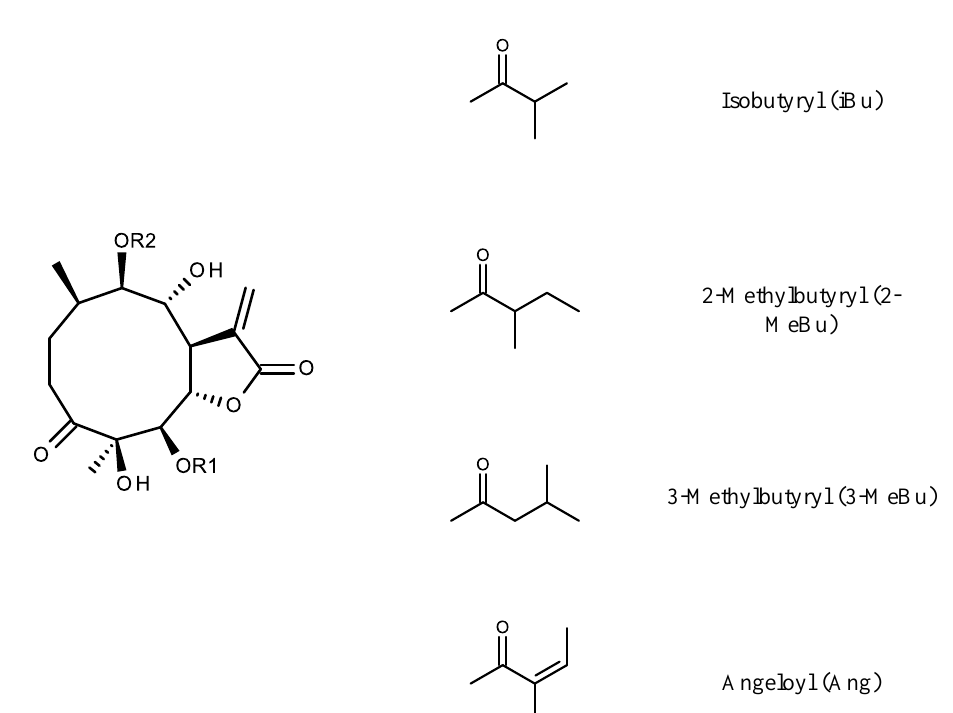
Figure 1. Chemical structures of 4β,8α-dihydroxy-5β-angeloyloxy-9β-(2-methylbutyryloxy)-3-oxo-germacran-6α,12-olide ( 1, R1 = Ang, R2 = 2-MeBu ), 4β,8α-dihydroxy-5β-angeloyloxy-9β-(3-methylbutyryloxy)-3-oxo-germacran-6α,12-olide ( 2, R1 = Ang, R2 = 3-MeBu ) and 4β,8α-dihydroxy-5β-isobutyryloxy-9β-(3-methylbutyryloxy)-3-oxo-germacran-6α,12-olide ( 3, R1 = iBu, R2 = 3-Mebu ).